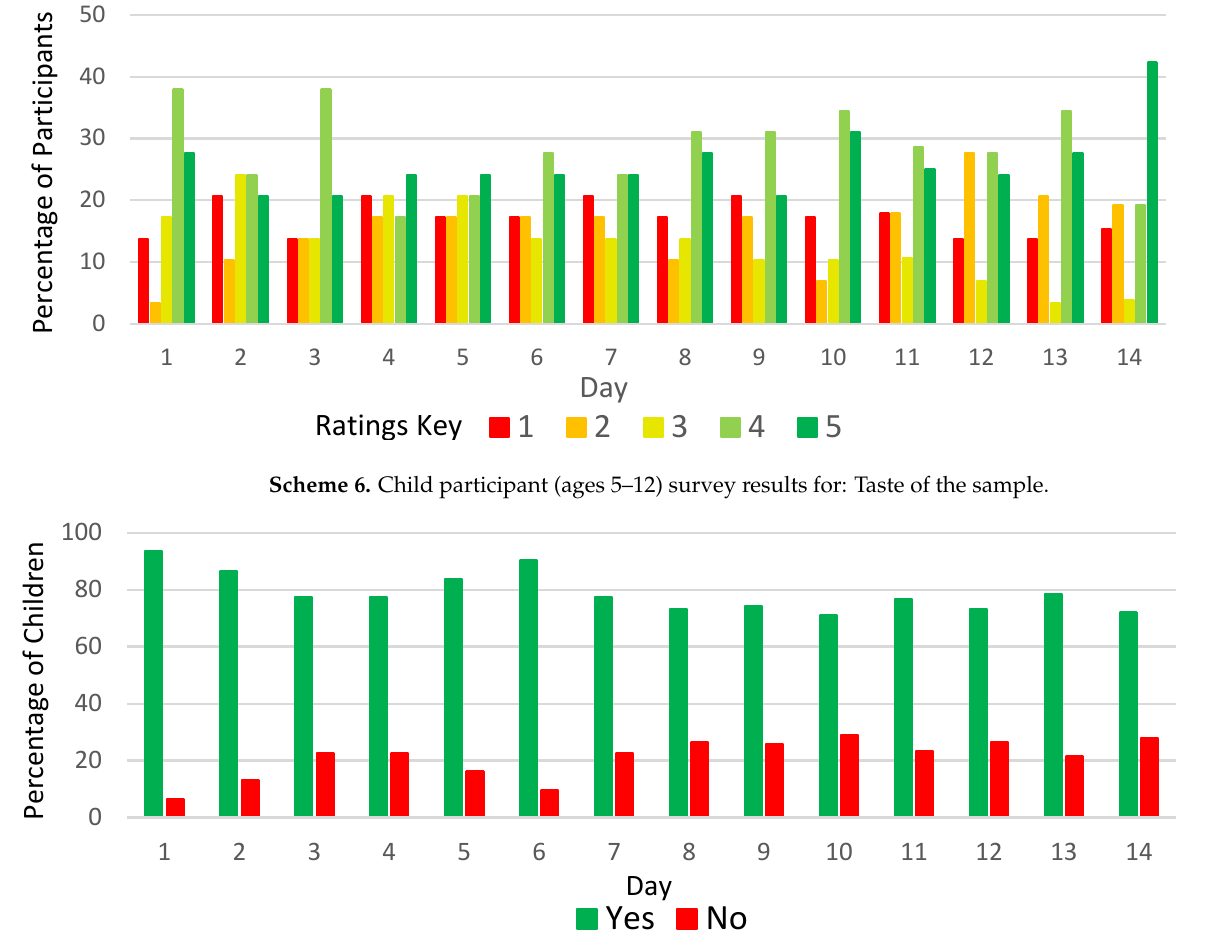
Scheme 6. Child participant (ages 5–12) survey results for: Taste of the sample